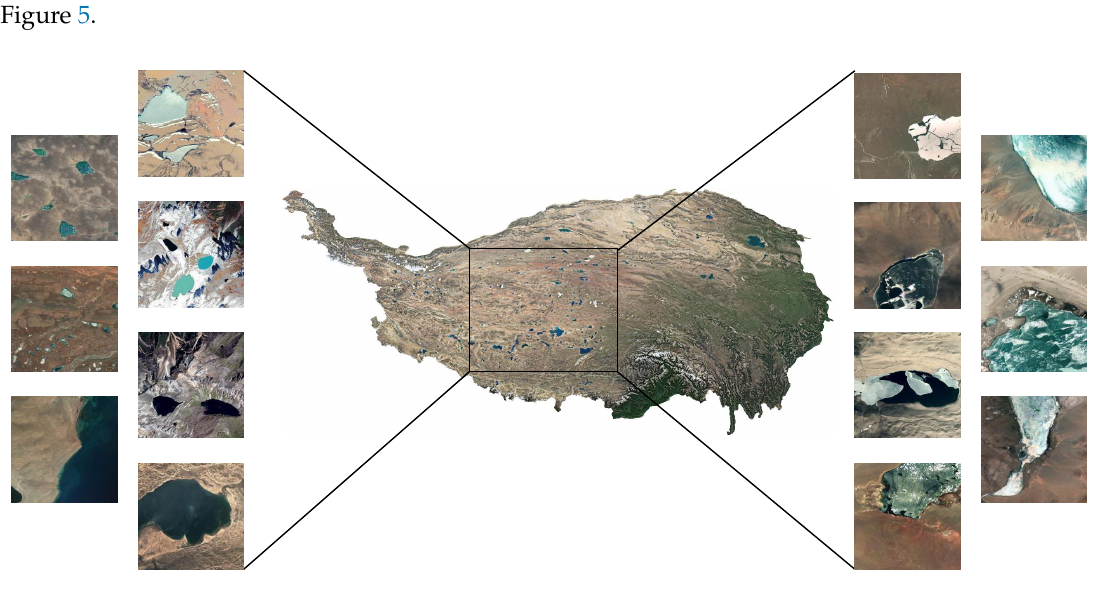
Figure 5. The study area of lake water bodies’